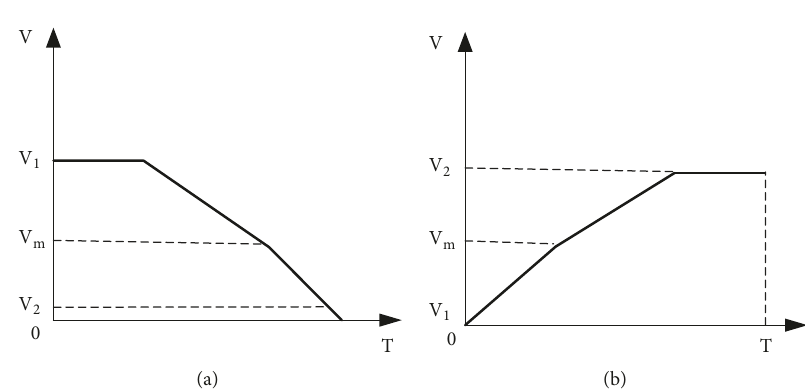
Figure 3: Trajectory reconstruction process.